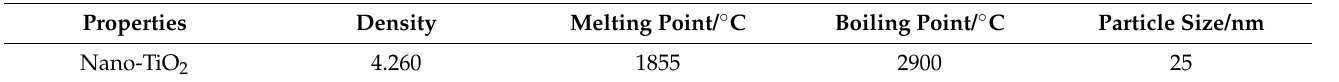
Table 2. Nano-TiO 2 properties.